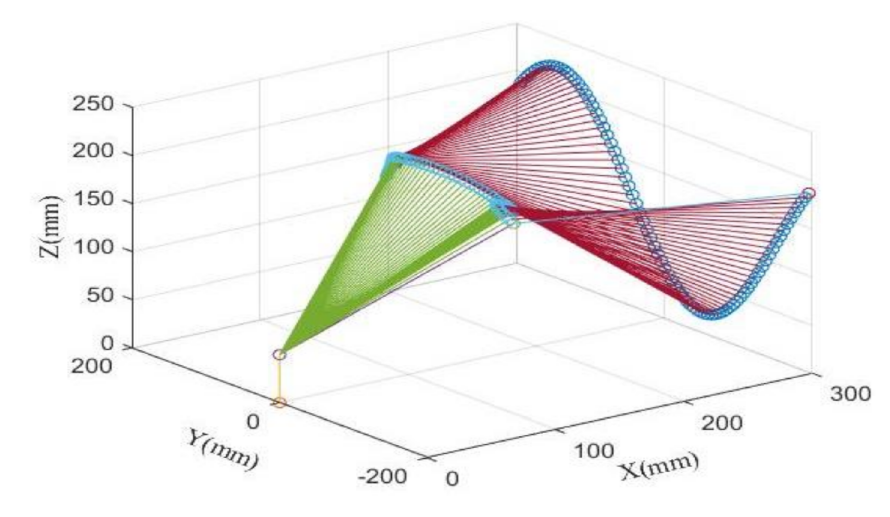
Figure 5. The trajectory of the end-effector command